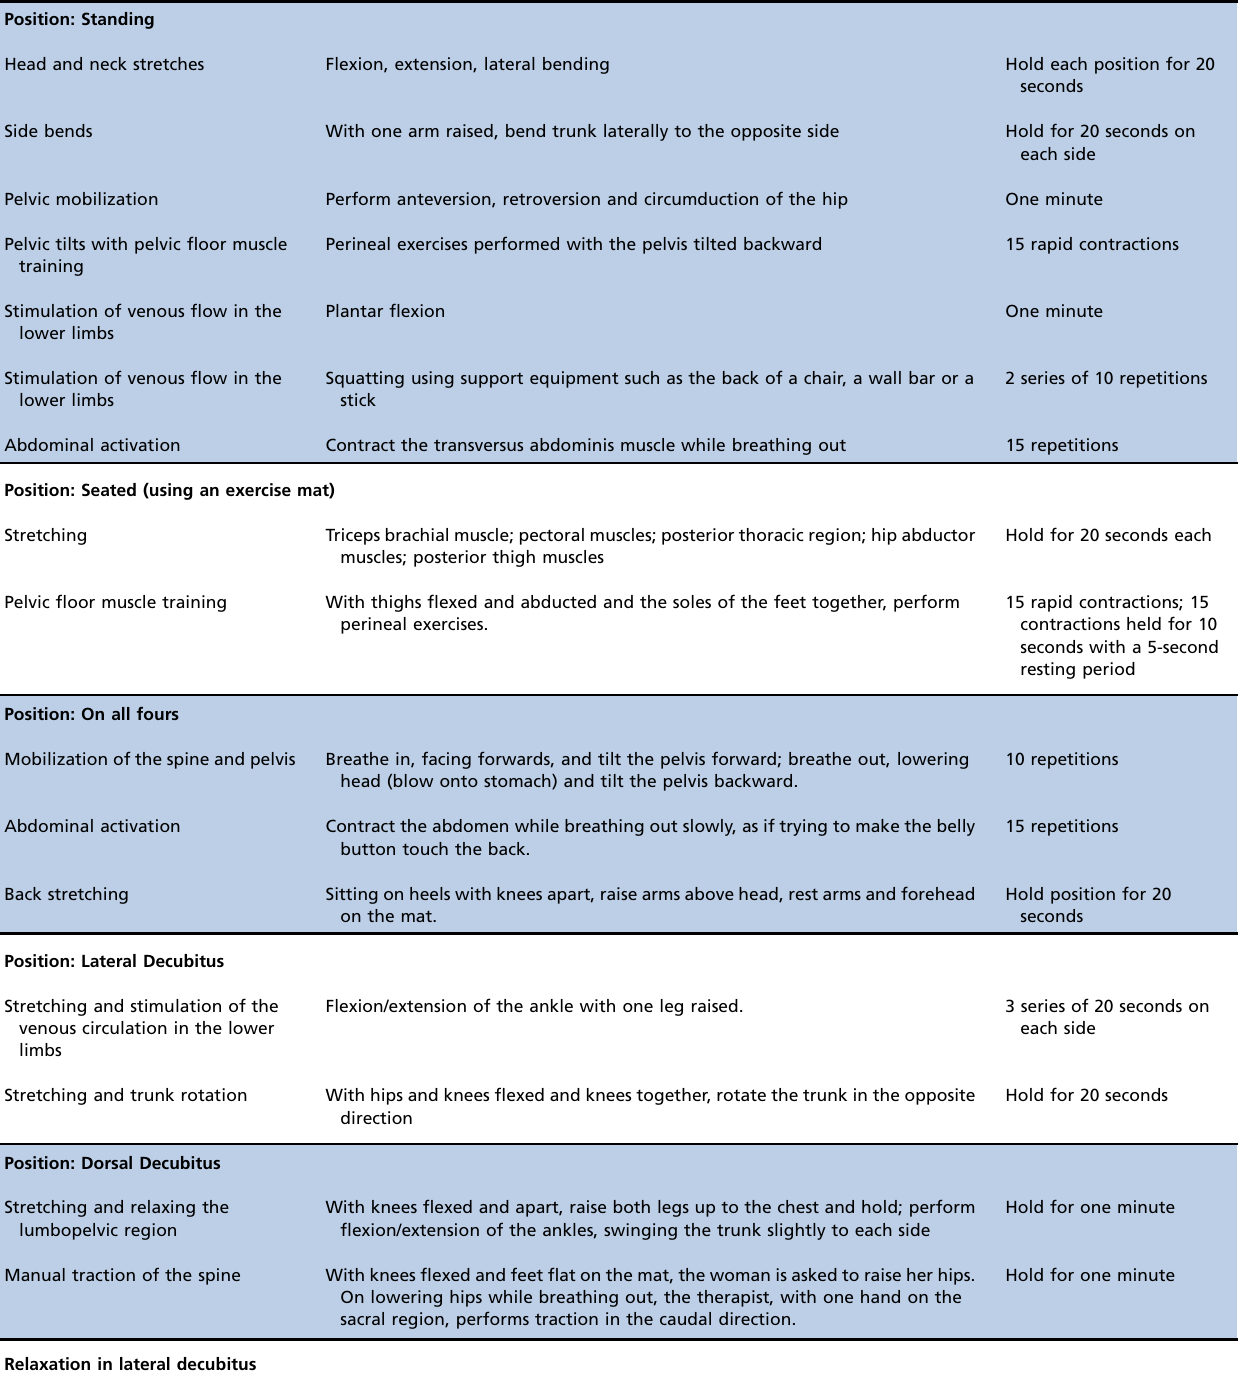
Table 1 - Protocol of supervised